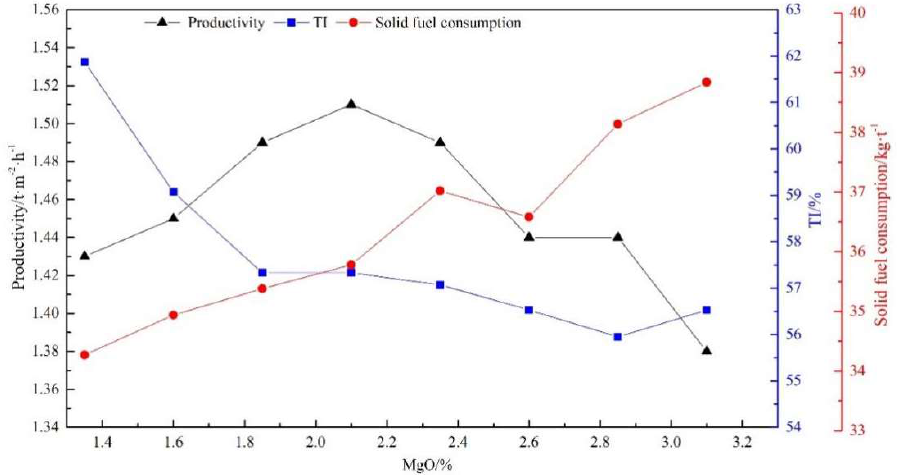
Figure 2. Sintering indexes with different MgO content of sinter (TI-tumble strength).